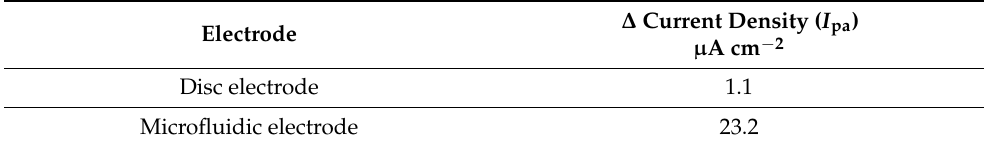
Figure 5. CV grams of the tetra-enzyme immobilized electrode: comparison of the microfluidic system electrode and the disc electrode. Table 1. Comparison of microfluidic electrode with disc electrode.